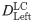
Example of viewpoint correction results for the cones [27] stereo pair.
(a): Cones left view of the pair. (b): Left viewpoint ground-truth. (c): Right viewpoint ground-truth. (d): Left–viewpoint DLeftLC. (e): Centre–viewpoint DCentreLC. (f): Right–viewpoint DRightLC. (g): Centre to Left viewpoint disparity shift. (h): Right to Left viewpoint disparity shift. (i): Fusion of the three Left (shifted) maps into D^LCV. Images (a), (b) and (c) are reprinted from Scharstein and Szeliski [26] under a CC BY license, with permission from Daniel Scharstein, original copyright 2003.